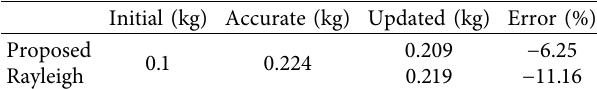
Figure 10: Comparison of experimental and initial analytical FRFs H 1,1 . Table 8: Values of the added mass before and after updating.